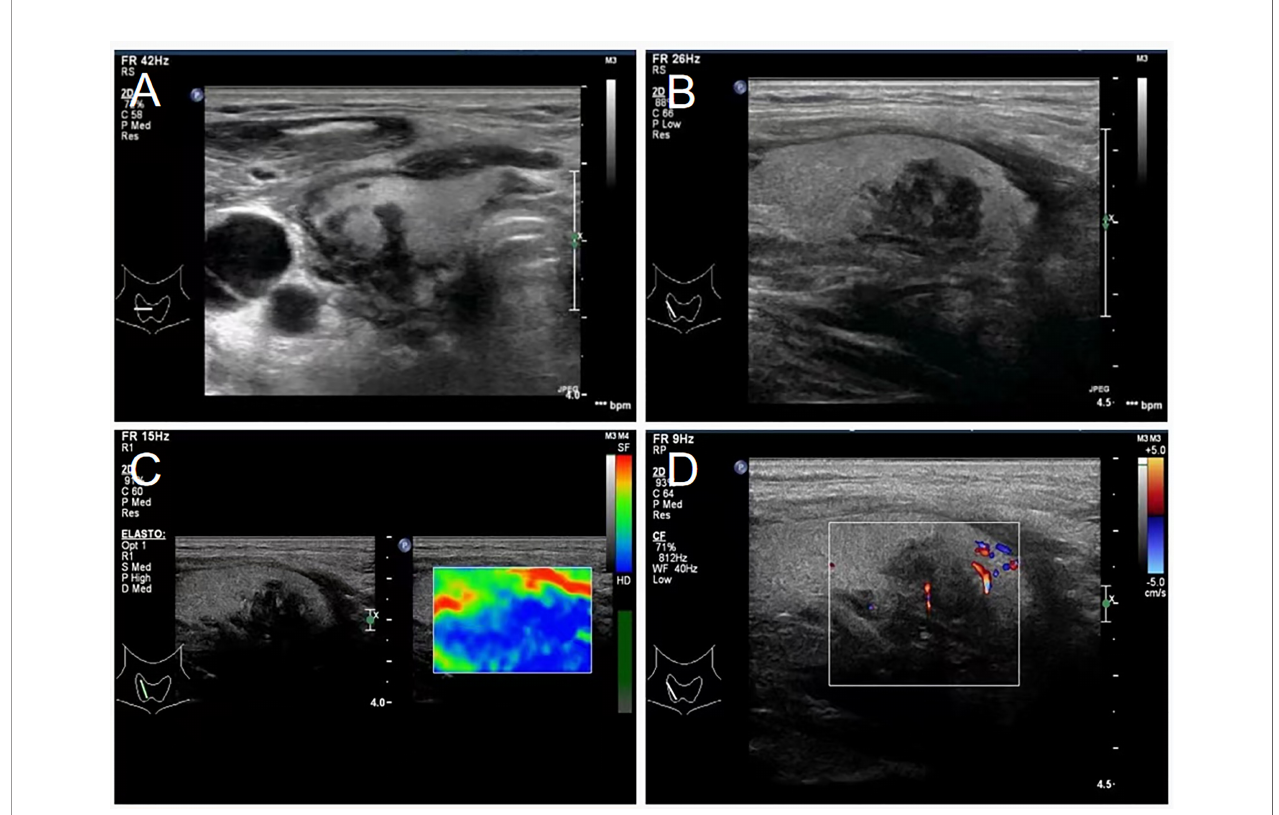
FIGURE 2 | Transverse and longitudinal ultrasound showing thyroid invasion. (A) Ultrasound transects of thyroid showing a hypoechoic, irregular, and ill-de fi ned thyroid at the right side. (B) Ultrasonography of the thyroid showing a low-echo area in the middle and lower part of the right thyroid gland, with an uneven internal echo, irregular shape, and unclear boundary. (C) Shear-wave elastography showing the hypothyroid area on the right as the essentially blue area. (D) Color Doppler ultrasonography showing minimal blood fl ow signal in the hypoechoic thyroid area.